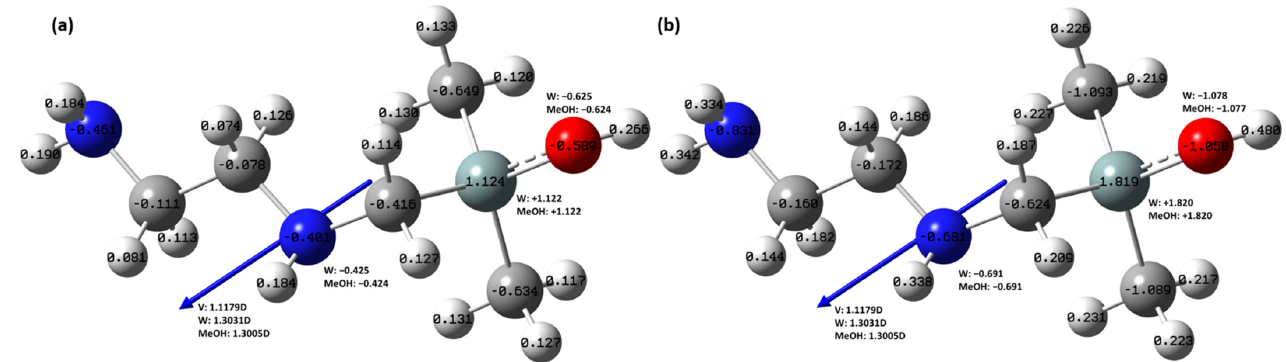
Figure 7. Partial charges for silanol: ( a ) Mulliken, ( b ) NPA from NBO; implicit solvents: W—water, MeOH—methanol, V—vacuum.